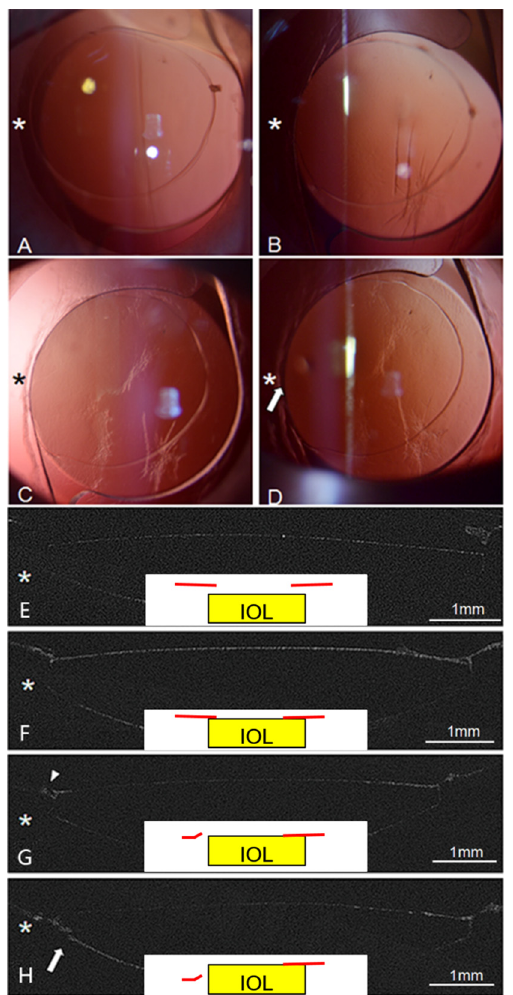
squares for IOLs. (A and E) On day 3 postoperatively, an incomplete overlap, anterior capsule not overlapping the IOL at 9 o ’ clock to 11 o ’ clock temporally existed, and no opacity were found in the posterior capsule. Neither nasal nor temporal side formed a capsular bend. (B and F) On day 7 postoperatively, the temporal side of the anterior capsule came close to the IOL, and the capsule partially wrapped around the optic edge because of posterior capsular contraction. LECs migrated into the center of the temporal posterior capsule. Both sides formed anterior adhesion types. (C and G) On day 14 postoperatively, the LECs elongated and integrated into a fibrous-like membrane. The anterior capsule detached from the temporal IOL optic edge (white triangle) and transformed into the detachment type, whereas the nasal side remained the anterior adhesion type. (D and H) On day 28, the entire posterior capsule was covered by LECs, and exacerbation of the posterior capsular contraction and increased thickness of the posterior capsule (white arrow) were present. The temporal and nasal sides remained the anterior detachment and anterior adhesion types,